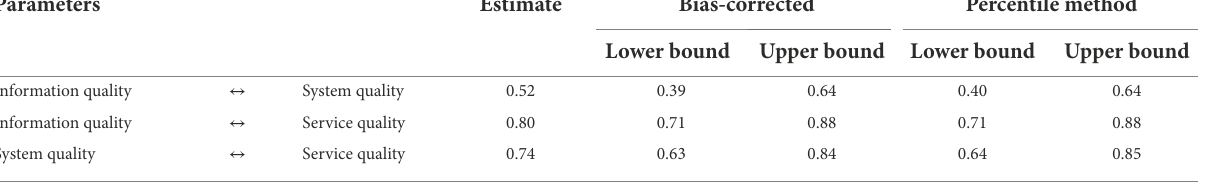
TABLE 6 Information system success model - bootstrap correlation coefficient 95% confidence interval.